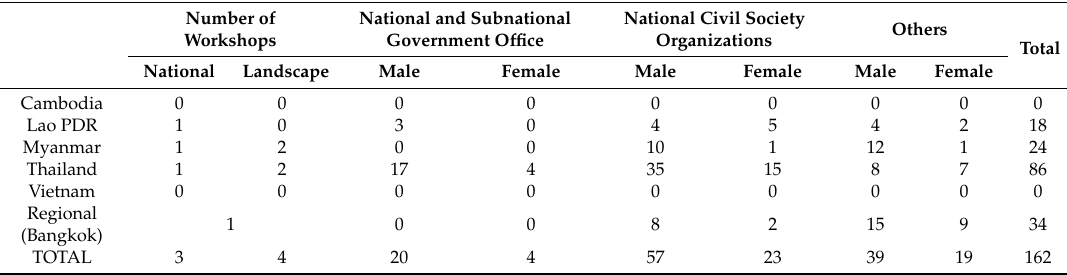
Table A3. Participants in results sharing and ways forward workshops in each GMS country. Number of